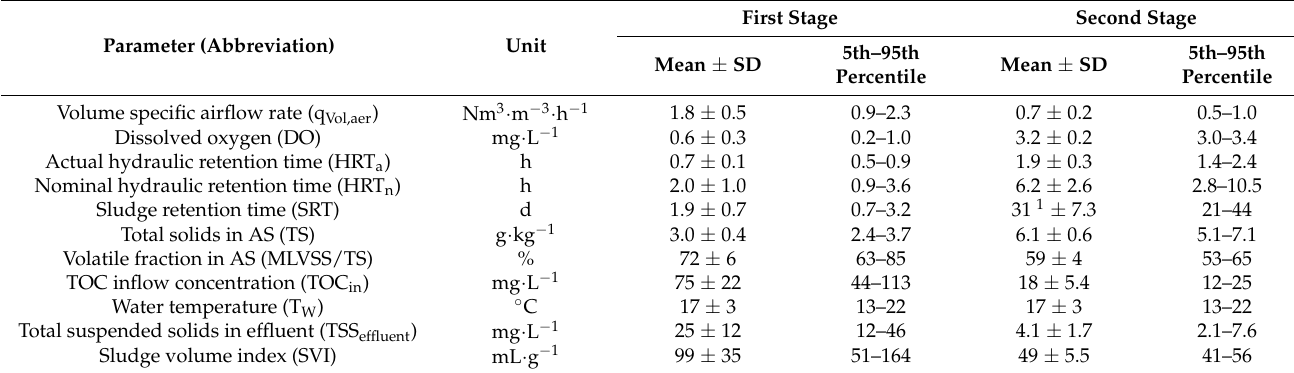
Table 1. Operating data of examined two-stage